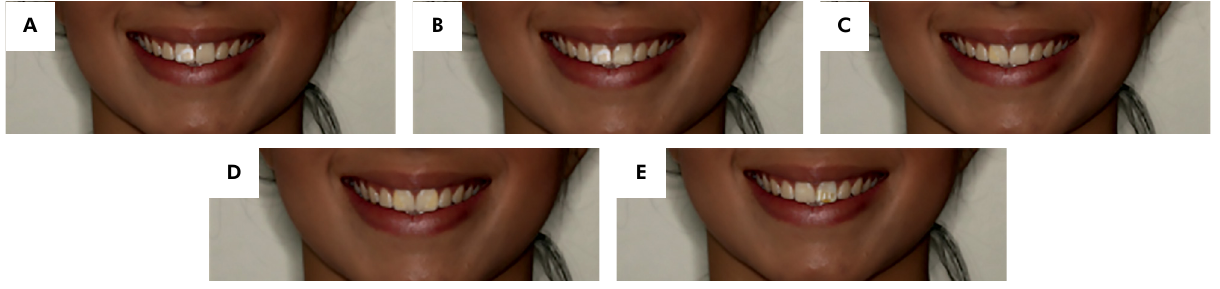
Figure 2. Opacity in the boy: A) Unilateral white opacity; B) Bilateral white opacity; C) Unilateral yellowish opacity; D) Bilateral yellowish opacity; E) Unilateral yellowish opacity + Enamel with loss of structure; F) Bilateral yellowish opacity + Enamel with loss of